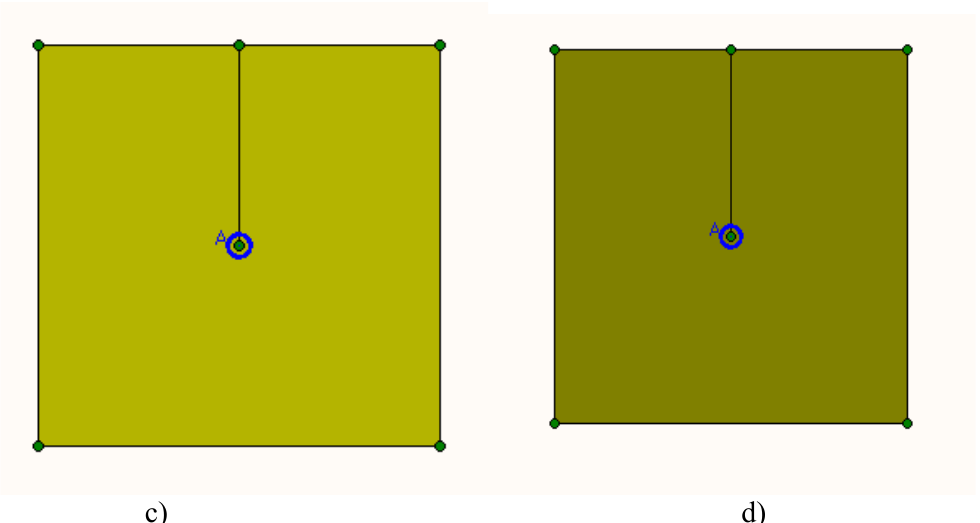
Fig. 8. System of load assigning. a) Geometry lines, b) Assigning load c) Assigning floor, d) Assigning footing as